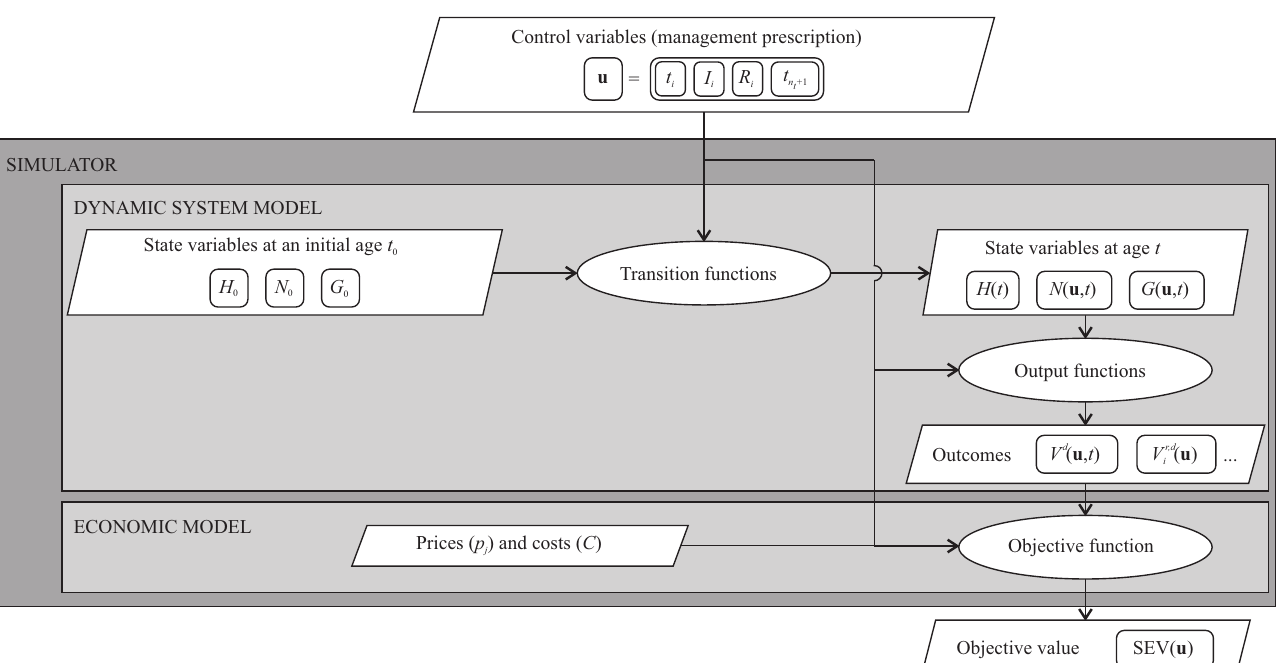
Figure 1. Flow diagram of the simulator developed for computing the objective value (SEV) of a given management